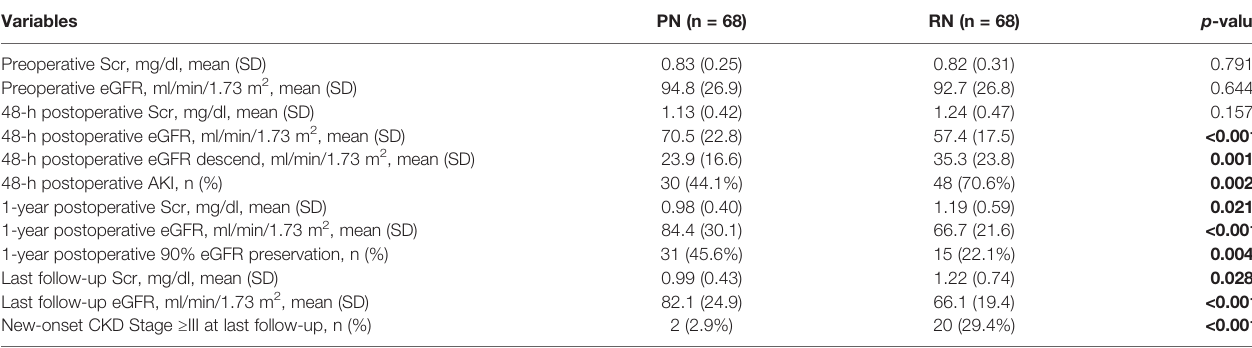
TABLE 3 | Preoperative functional outcomes for PN and RN after propensity score matching. Variables PN (n = 68) p -value Preoperative Scr, mg/dl, mean